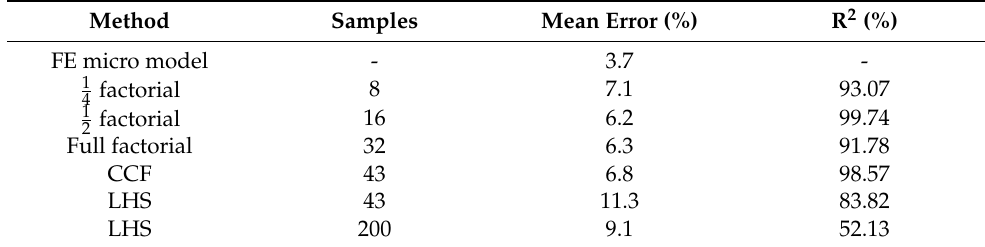
Table 5. Mean error of the regression models compared to the strength of